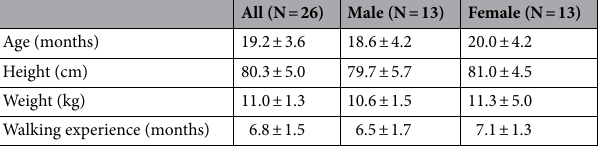
Table 2. Characteristics of participating toddlers. Data are shown as mean ±